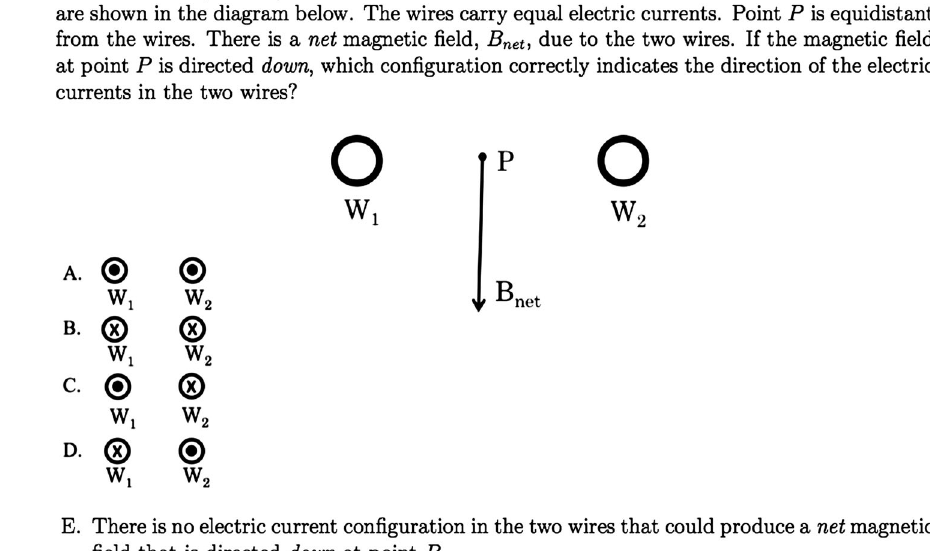
FIG. 2. Question 4, an example of one of the least difficult questions, from the EMCA assessment.